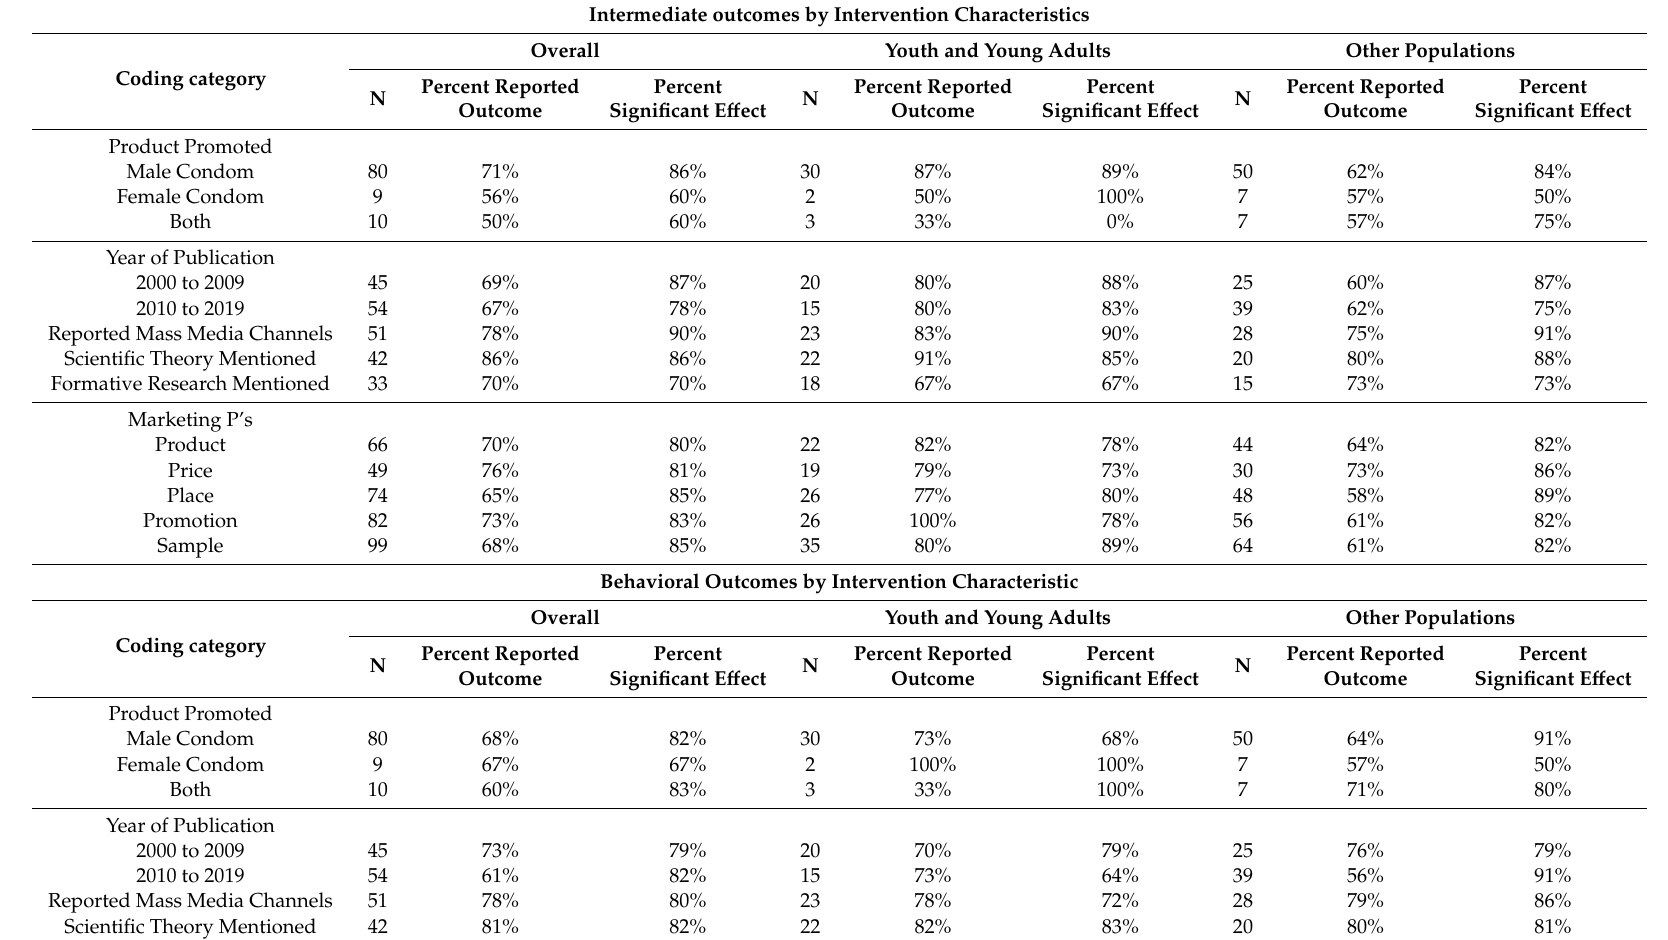
Table 6. Outcomes by intervention